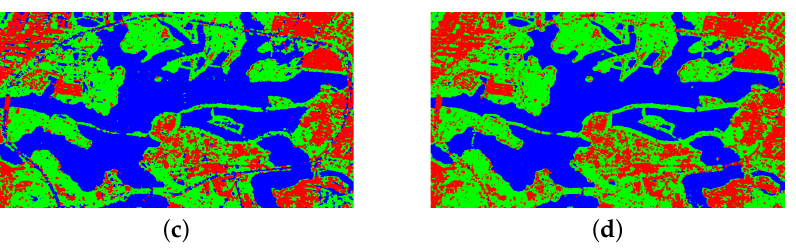
Figure 7. Classification maps of different classifiers on data set A. ( a ) Decision Tree. ( b ) Random Forest. ( c ) support vector machine (SVM). ( d ) XGBoost.